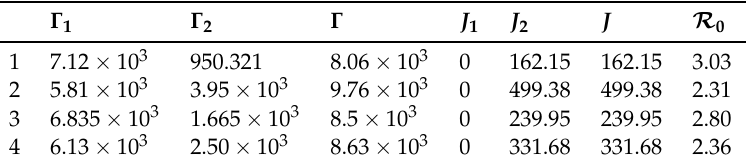
Table 3. The total number of newly infected animals over a ten-year period and the total cost J with respect to the control strategy under Scenario 1.